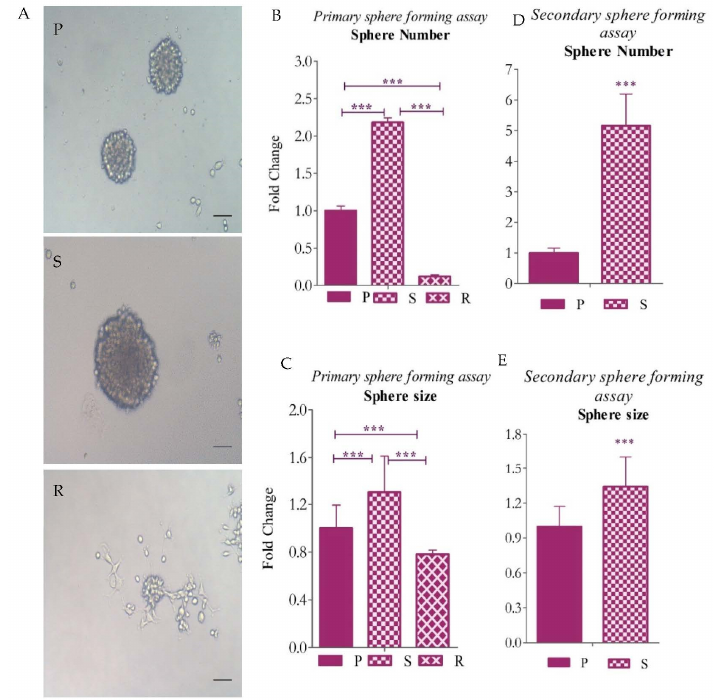
Figure 6. Morphology and sphere number and size of isolated and enriched CSCs in U87 cells. ( A ) Morphology of spheres of P, S and R, respectively, after 6 days of incubation in non ‐ adherent culture conditions; ( B , C ) sphere number and size of spheres in primary sphere ‐ forming assay; and ( D , E ) sphere number and size of spheres in secondary sphere ‐ forming assay. The graphical data are presented as mean ± SD, and the statistical analysis was performed using one ‐ way ANOVA (***: p ‐ value < 0.001). The scale bar indicates 20 μ m. Int. J. Mol. Sci. 2022 , 23 , x FOR PEER REVIEW To understand the colony ‐ forming potential of the enriched cells in anchorage ‐ inde ‐ pendent conditions, we performed the gold standard soft agar assay. After incubating the same number of cells in soft agar for 25 days, we observed that the trypsin ‐ sensitive pool of cells displayed better clonogenic potential in comparison to the other two. It was ob ‐ served that the colonies formed by S cells were bigger in size and number. Single cells incapable of self ‐ renewal were observed in the R pool. These cells showed very few colo ‐ nies. However, most colonies were very small (Figure 7). The data were in concordance with the ability to form spheres in these cells and further confirmed the presence of CSCs in the S pool and their absence the R pool.